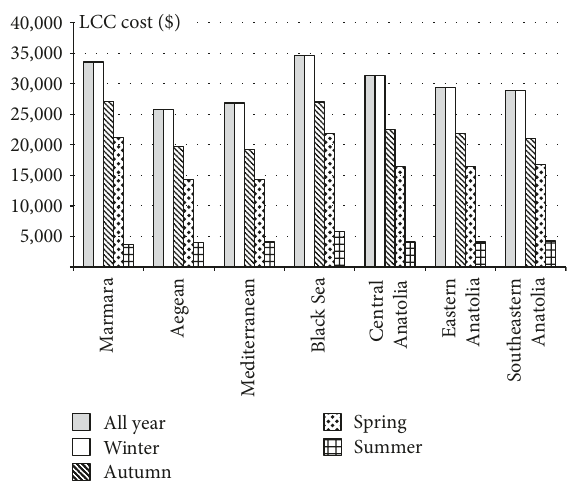
Figure 3: Changes in LCCs by scenarios and geographical regions.